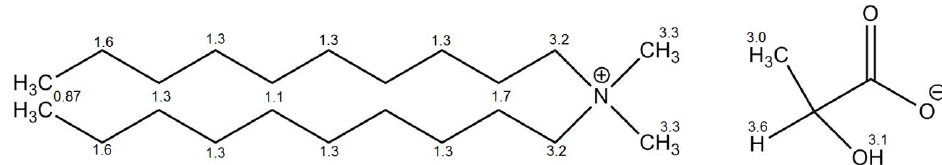
Figure 9. TOF-SIMS spectra for C 3 H 5 O 3 Zn + ion recorded for: ( a ) pure DDALa; ( b ) DDALa and ZnO mixture with the weight ratio of 1:1; ( c ) DDALa and ZnO mixture with the weight ratio of 1:2; (*lactate anion of DDALa).